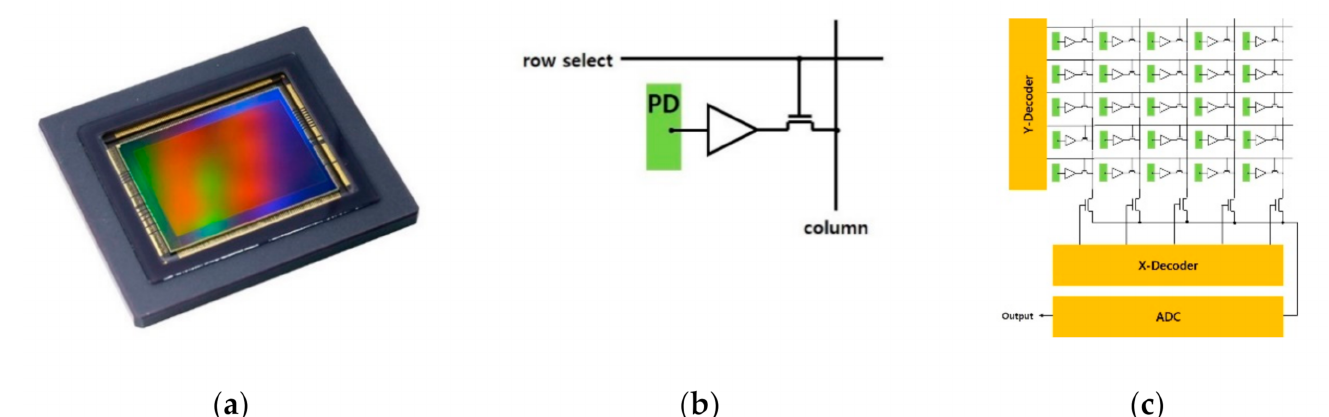
Figure 1. Complementary metal oxide semiconductor (CMOS) Image Sensor: ( a ) CMOS Sensor for industrial vision (Canon Inc., Tokyo, Japan); ( b ) Circuit of one pixel; ( c ) Pixel array and Analog Frontend